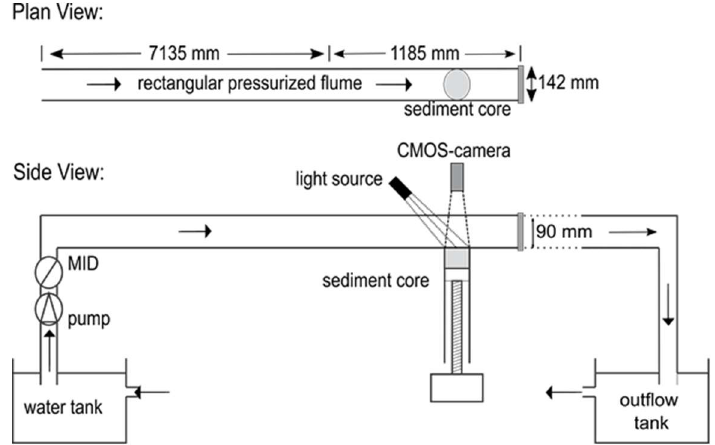
Figure 1. Schematic overview of the SETEG-flume including the experimental setup of PHOTOSED to measure high-resolution erosion rates of cohesive sediments (modified from [22,26,27]).